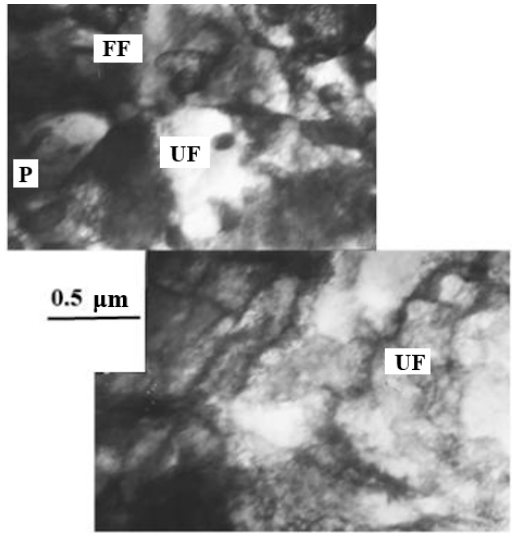
Figure 9. 0.12C-1Cr-1Mo-1V steel, initial state. Zone of localized deformation. Ferrite-perlite mixture (P—pearlite grain, UF—unfragmented ferrite grain, FF—fragmented ferrite grain). Transmission electron microscopy.